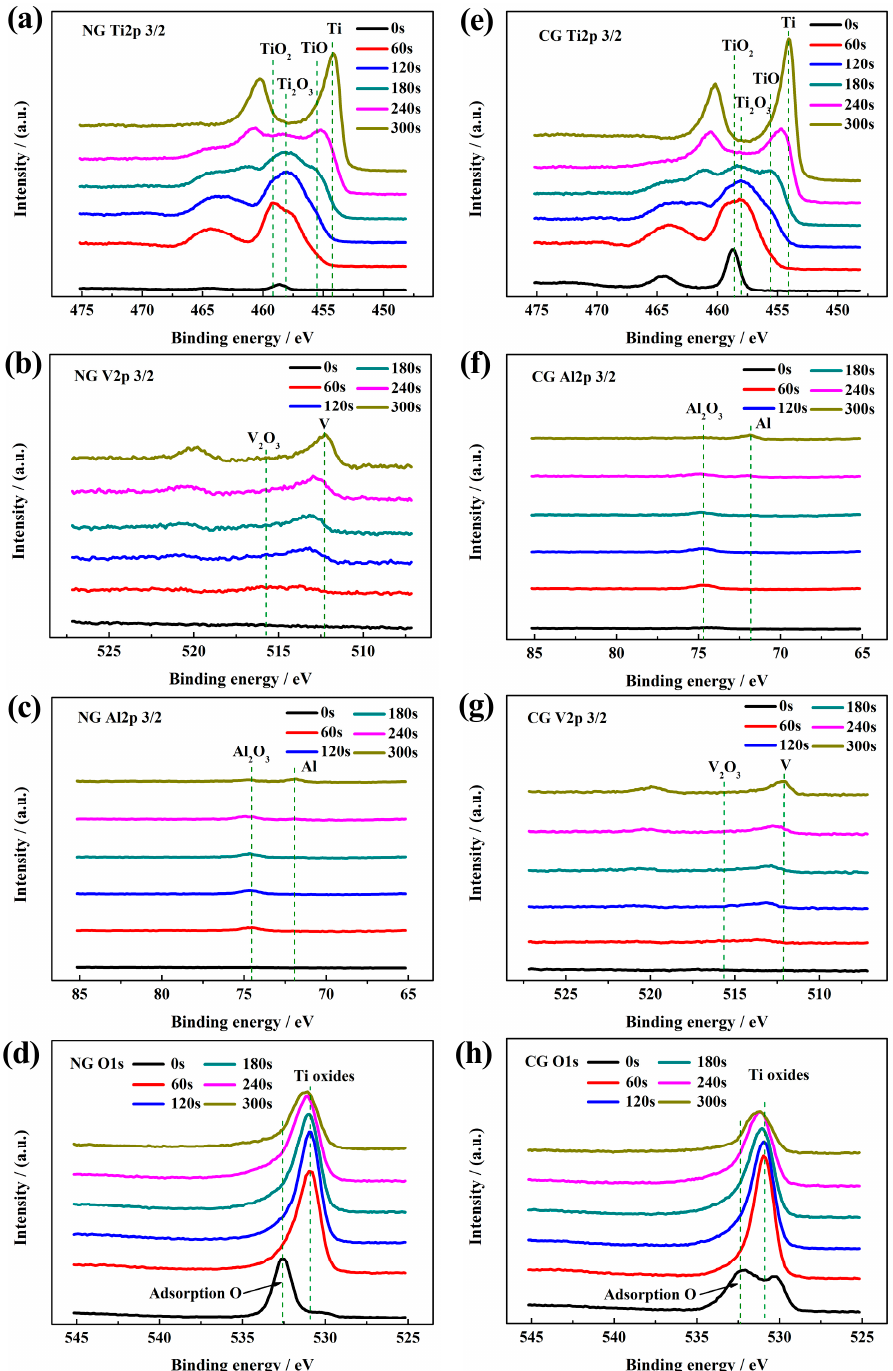
Figure 4. High-resolution XPS spectra of NG and CG Ti–6Al–4V alloys after polarization with different sputtering depths: ( a and e ) Ti 2p, ( b and f ) Al 2p, ( c and g ) V 2p, and ( d and h ) O 1s.